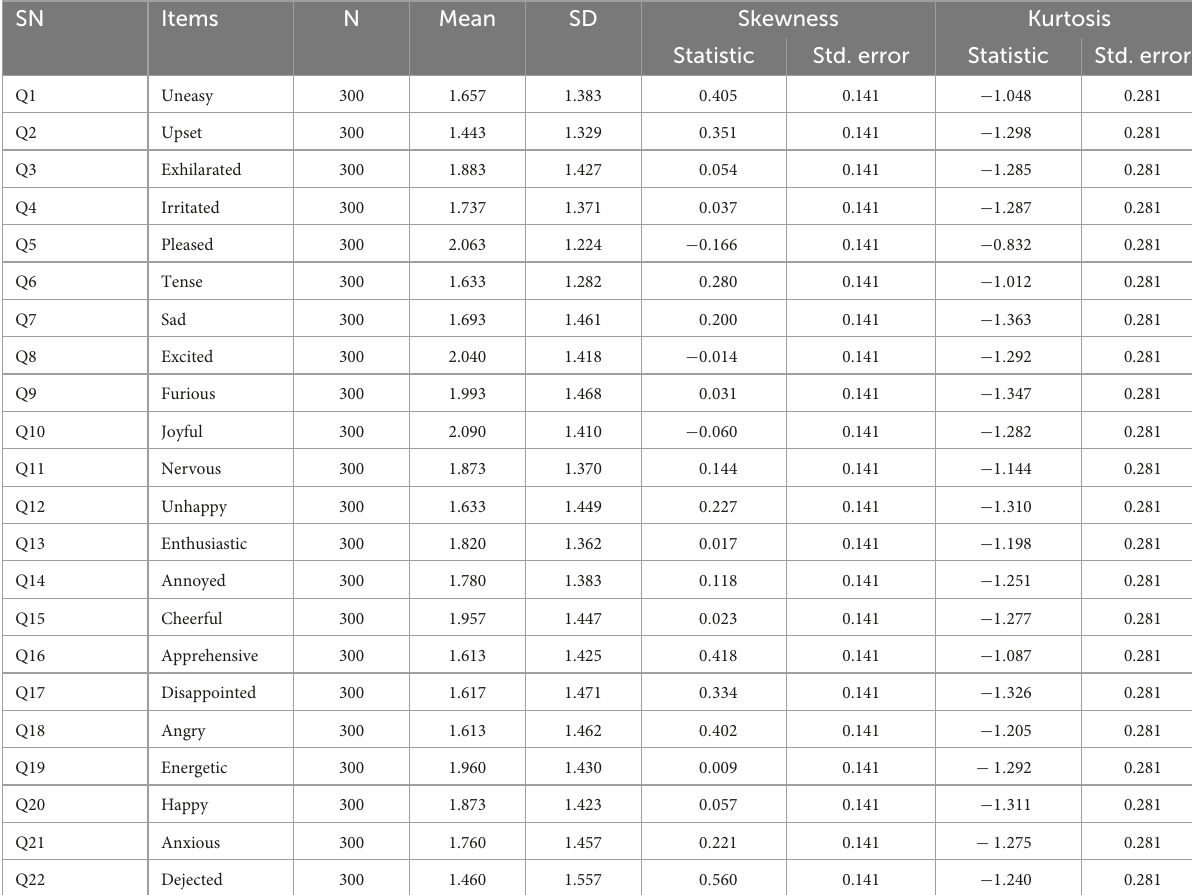
TABLE 1 Mean, standard deviation, skewness and kurtosis of the SEQ